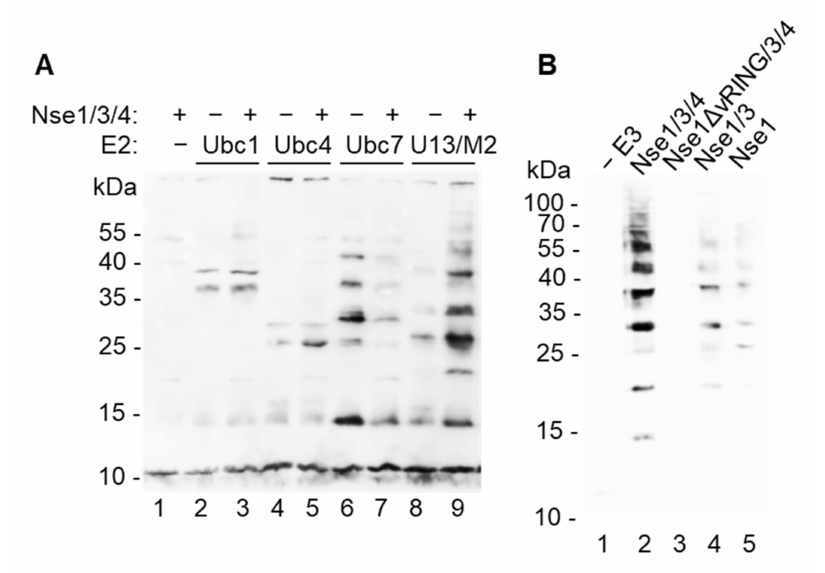
Figure 1. S. pombe Nse1 promotes in vitro ubiquitination together with Ubc13/Mms2. ( A ) Nse1 stimulates ubiquitin-chain formation when combined with Ubc13/Mms2. S. pombe E1 (Uba1), indicated E2s, biotinylated ubiquitin, ATP, and MgCl 2 were incubated in the presence or absence of Nse1/3/4 trimer for 1 h at 37 ◦ C. The mixture was separated on 12% SDS–PAGE followed by Western blotting and visualization of biotinylated ubiquitin using Streptavidin-HRP. Numbers on the left indicate molecular weights of protein standards (in kDa). ( B ) Nse1/3/4 trimer promotes ubiquitination more efficiently than Nse1/3 dimer or Nse1 alone, and deletion of its vRING domain ablates this activity. In vitro ubiquitination assay was performed using E1, Ubc13/Mms2, biotinylated ubiquitin, indicated E3, and analyzed as in ( A